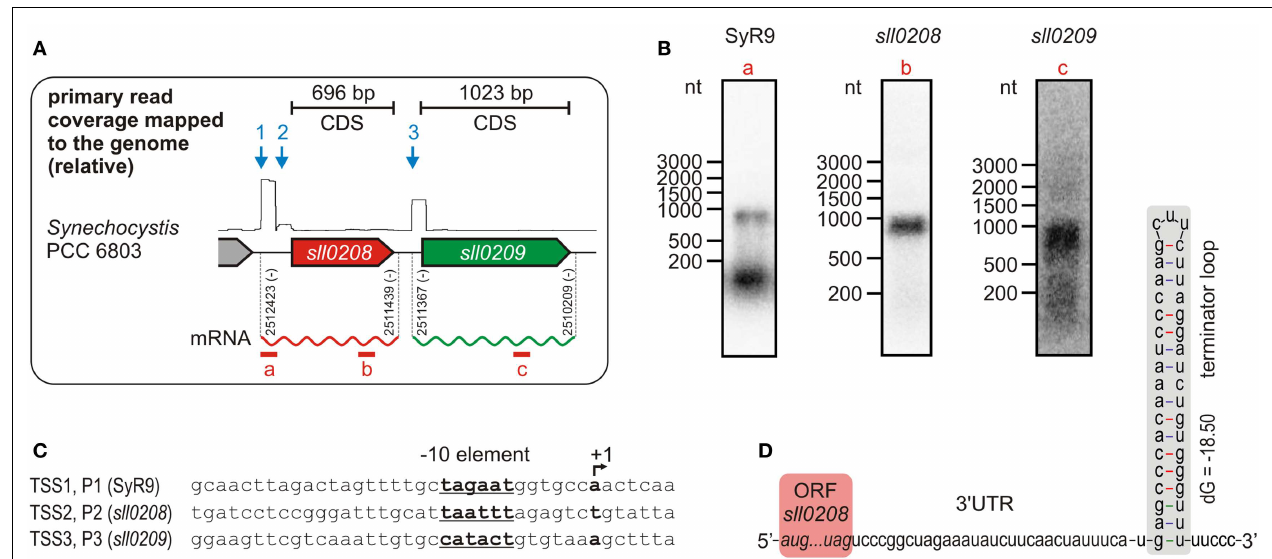
The experimentally confirmed 5 (cid:48) and 3 (cid:48) ends of the main mRNAs are given by the respective genomic positions. (B) Northern verification for the monocistronic mRNAs and the small transcript SyR9, which accumulates independently from the sll0208 mRNA in Synechocystis sp. PCC 6803.The part covered by the labeled probe is shown by a red bar in (A) . Consistent with theTSS mapping all transcripts detected appeared too short for a dicistronic mRNA. (C) Putative promoter elements upstream of the mapped TSS which is designated as + 1. (D) The mapped 3 (cid:48) end of the sll0208 mRNA can be folded into a stem loop secondary structure that is typical for a Rho-independent terminator of